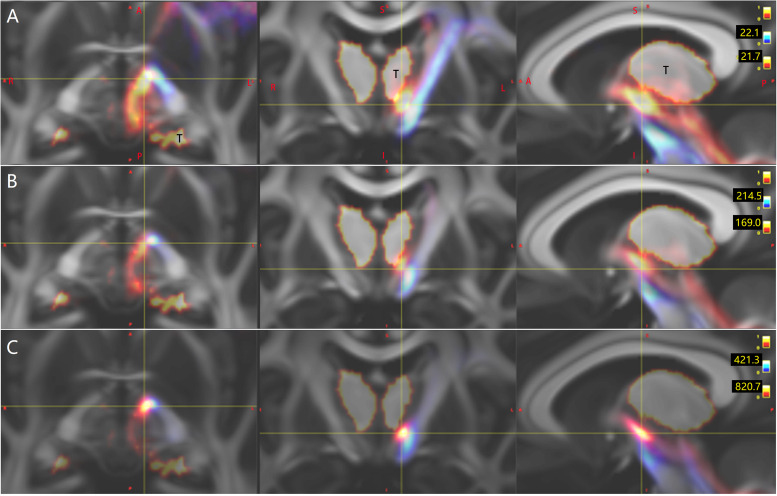
Tridimensional views of the pathways of Crus–Broca tracts that bypass the left thalamus. The pathways of Crus–Broca tracts (hot color)/Broca–Crus tracts (cold color) from all subjects as reconstructed via DSI Studio (A), FSL (B), or MRtrix3 (C). At the group level, Crus–Broca tracts bypass the left thalamus [denoted by “T” in (A)]. The focus in each image denotes the voxel cluster where the tracts most commonly go through but is outside of the left thalamus.